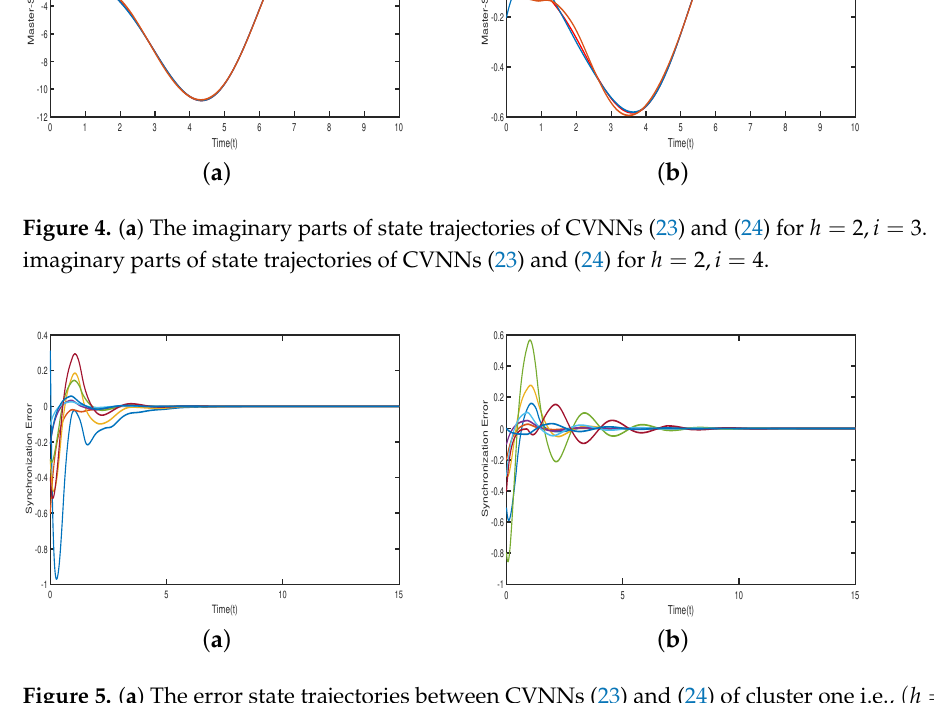
Figure 5. ( a ) The error state trajectories between CVNNs (23) and (24) of cluster one i.e., ( h = 1, i = 1,2 ) . ( b ) The error state trajectories between CVNNs (23) and (24) of cluster two i.e., ( h = 2, i = 3,4 )